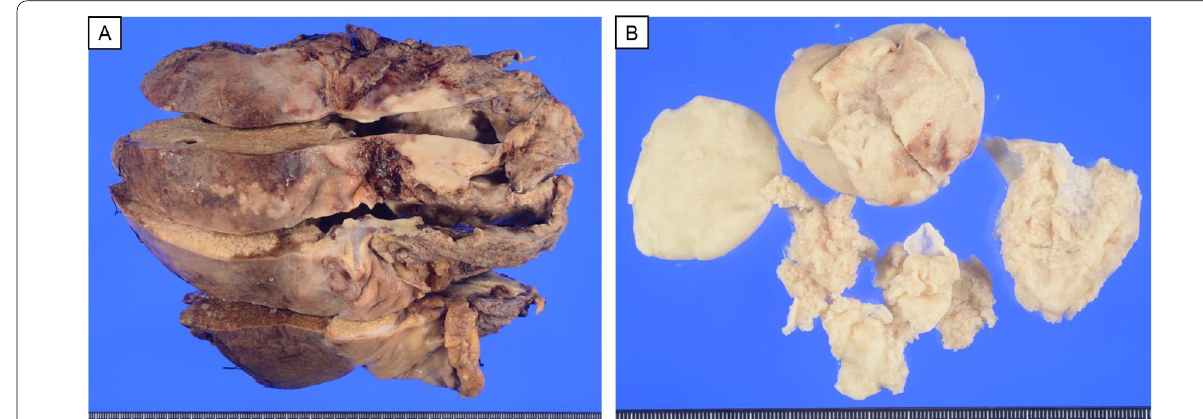
Fig. 4 A Removal of the left side of the liver. B. The white cystic structure removed from the pericardium